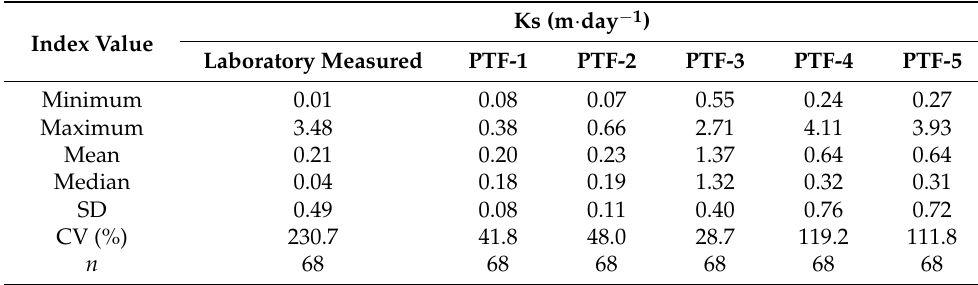
Table 6. Basic descriptive statistics for soil hydraulic conductivity (Ks) over all